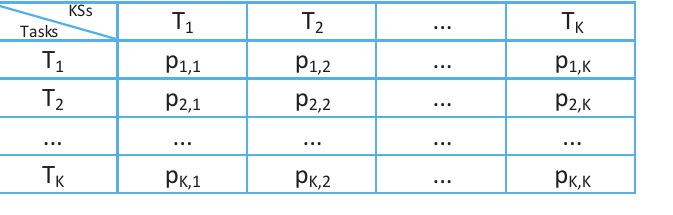
Figure 2. The learned probabilities on K knowledge sources (denoted as KSs ) for every task at generation g